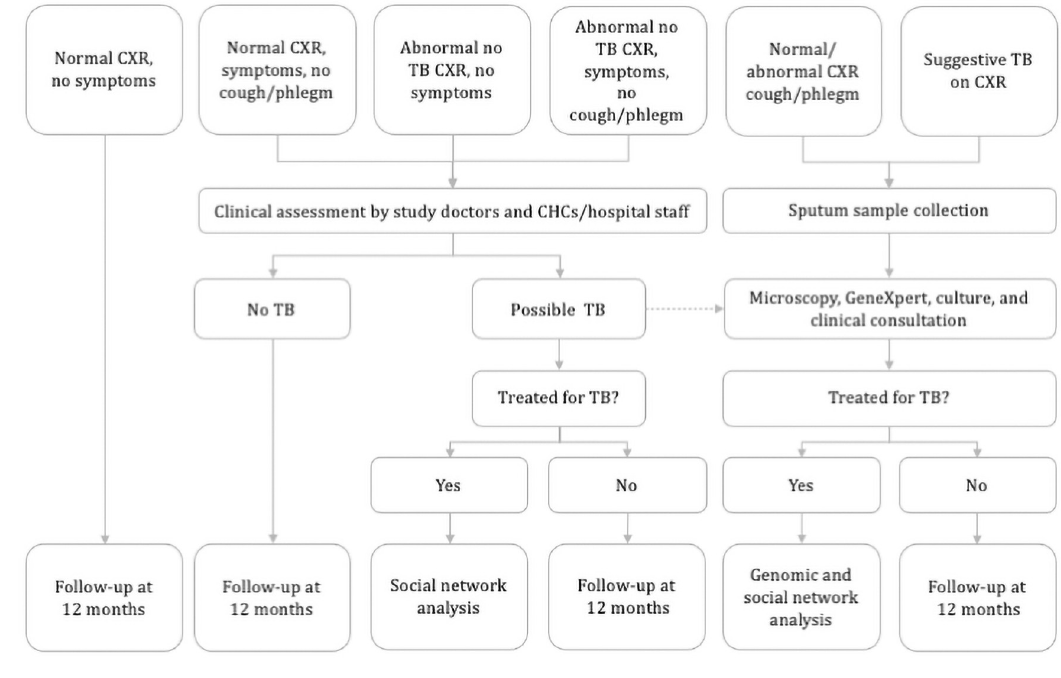
Fig 2. Baseline screening